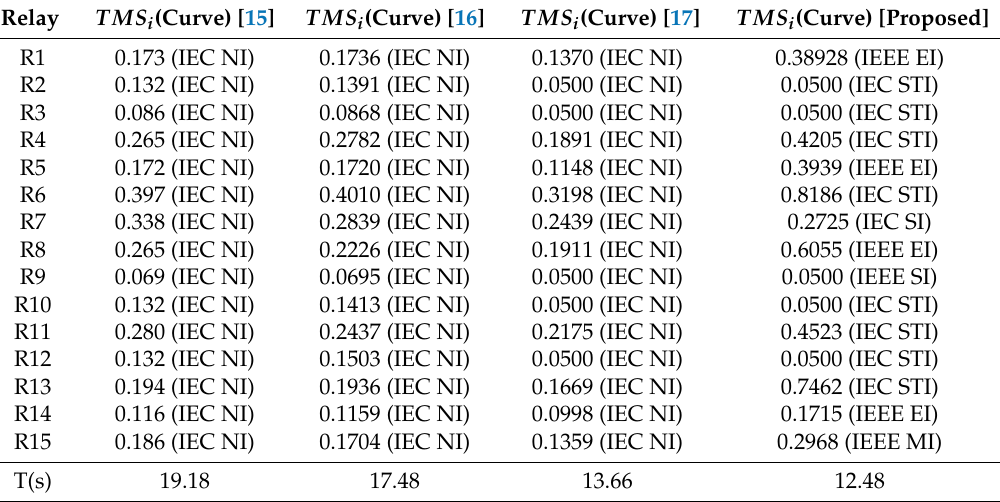
Table 6. Coordination parameters for OM2.